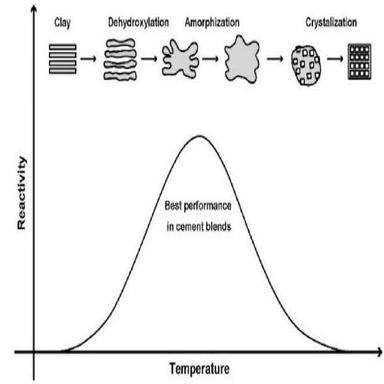
Clay phases transformation at different calcined temperatures, adapted from Ref..